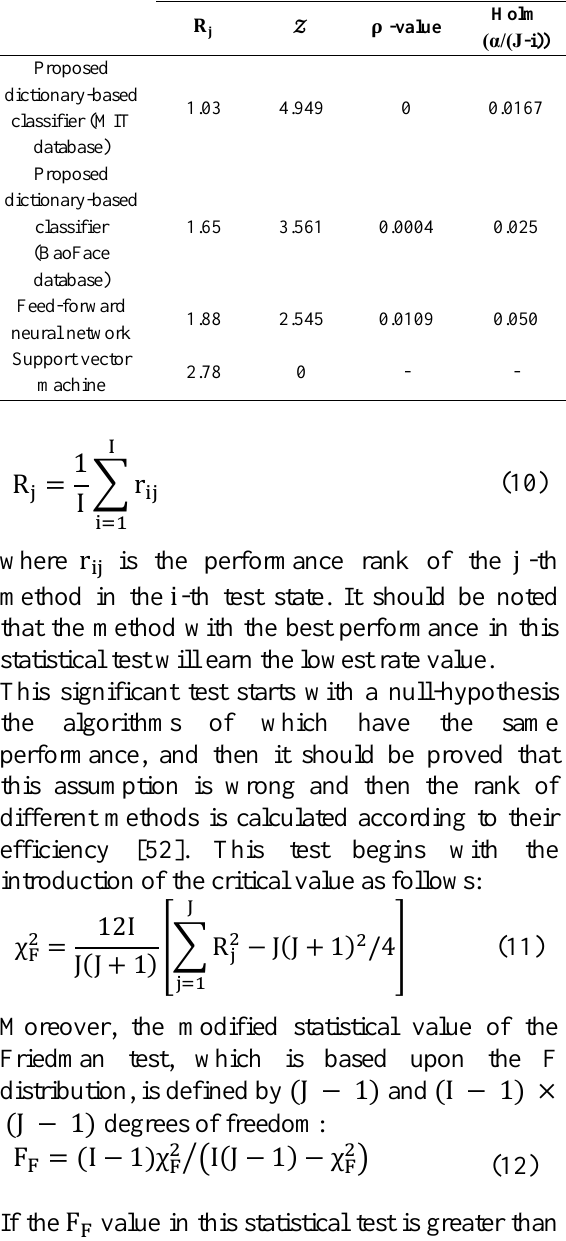
8 Support vector machine